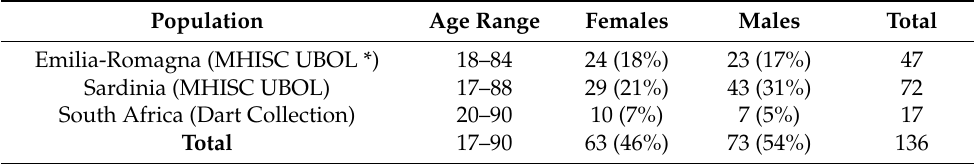
Table 1. Sample composition by populations, age range, and sex. Population Age